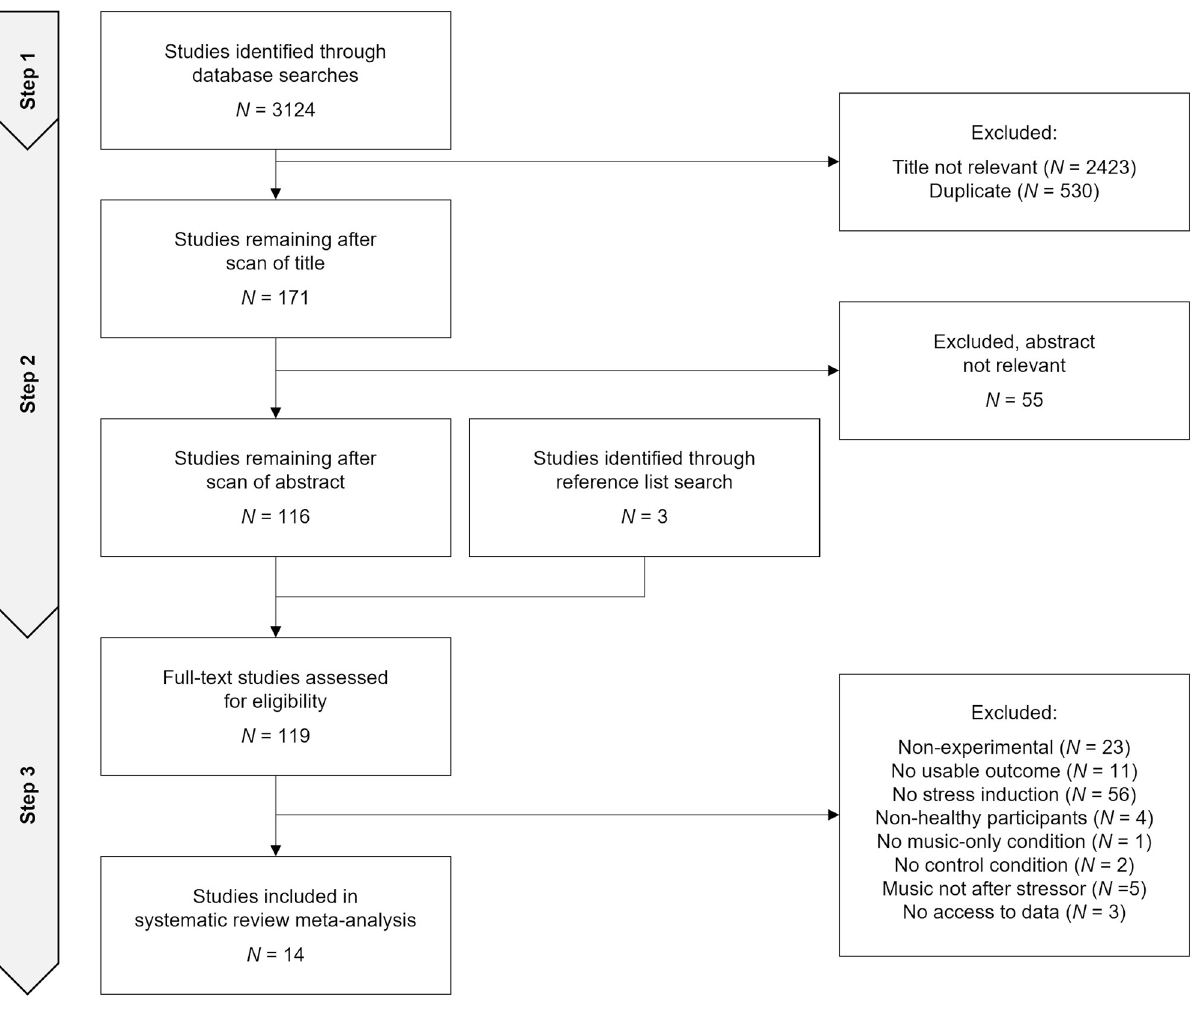
Fig 1. Overview of the study selection